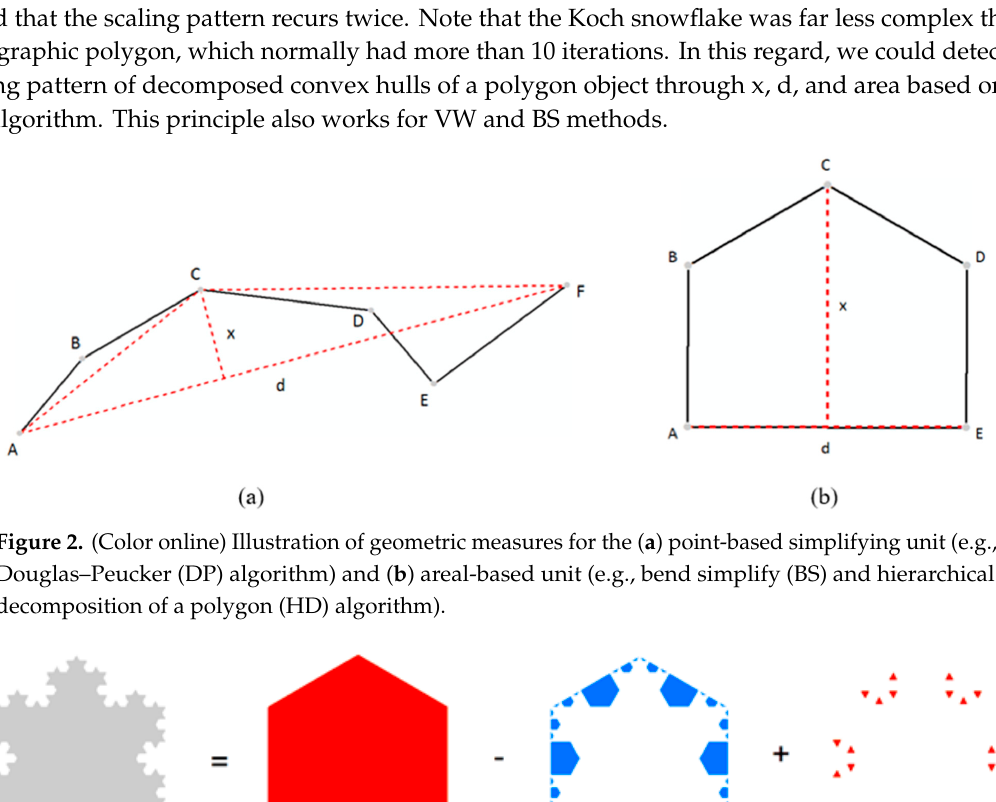
Figure 3. (Color online) Illustration of the HD algorithm using the Koch snowflake as a working example. Note that the size of derived convex hulls holds a striking scaling hierarchy of far more small ones than large ones.